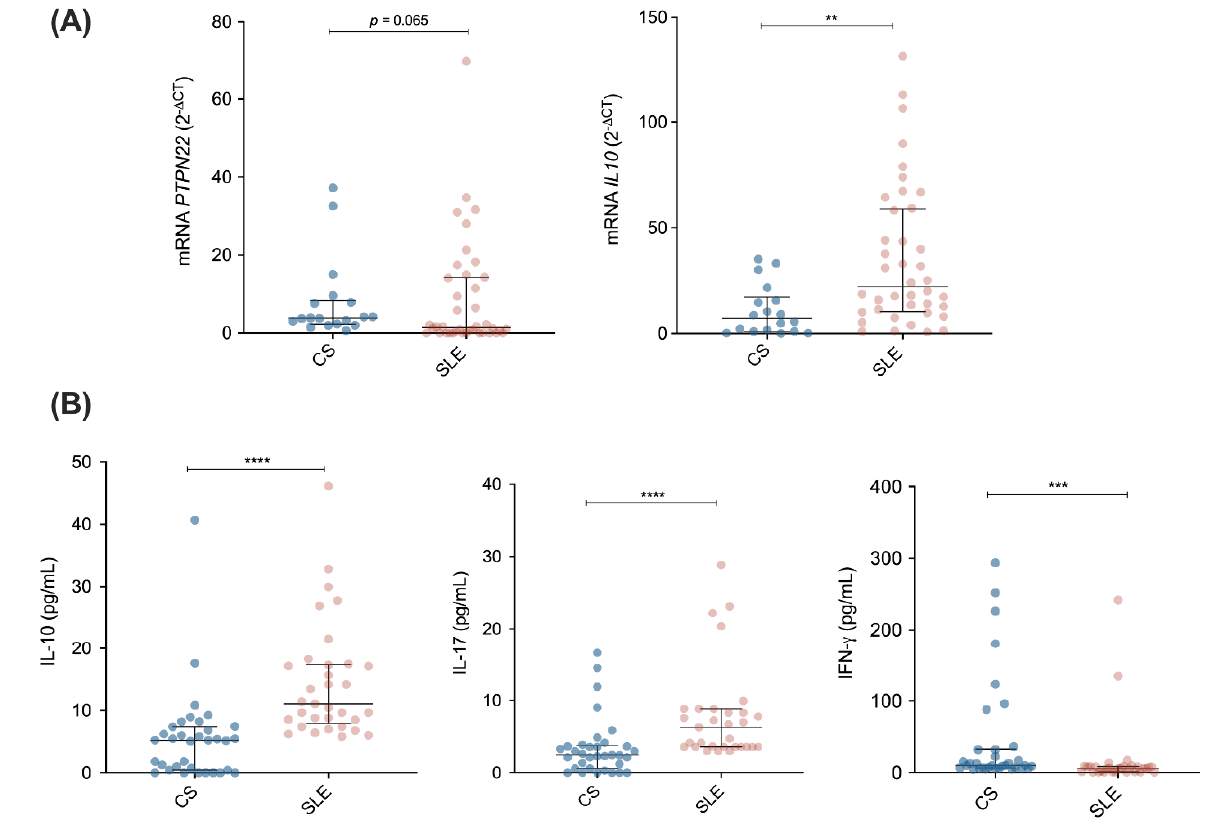
Figure 1. mRNA and cytokine levels in SLE patients and control subjects (CS). ( A ) mRNA expression of PTPN22 and IL10 genes determined by the 2 − ∆ Cq method in CS ( n = 18) vs. SLE patients ( n = 40); ( B ) Serum levels of IL-10, IL-17, and IFN- γ cytokines in CS ( n = 34) vs. SLE patients ( n = 31). Data are presented in median (p25 – p75). Differences between groups were determined using Mann – Whitey U test. ** p < 0.01, *** p < 0.001, **** p < 0.0001.